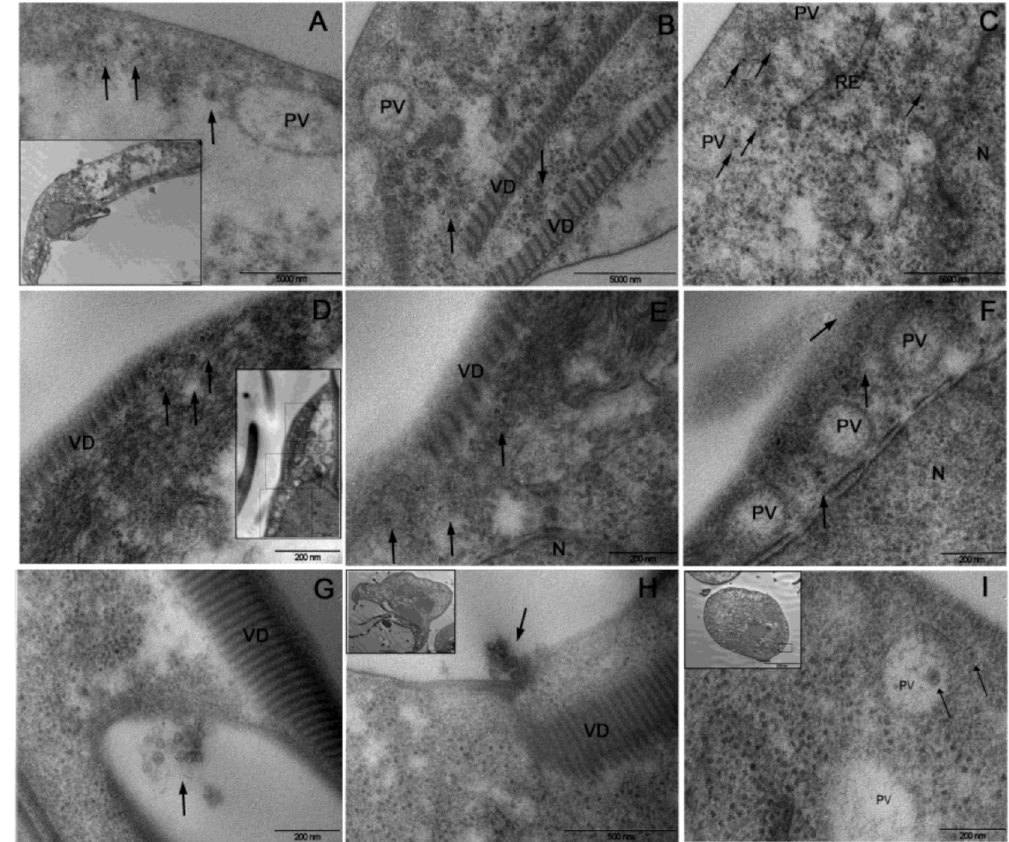
Figure 6. Transmission electron microscopy analysis of WBC6 CAT and G. duodenalis WBC6 HP tropho- zoites. ( A – C ) Electron micrographs of WBC6 CAT trophozoites (inset) at high magnification show GLVs particles localized near peripheral vesicles (Pvs) under periplasmatic membrane ad near the ventral dish. ( D – F ) Electron micrographs of WBC6 HP trophozoites (inset) at high magnification show GLV’s virus particles grouped principally under periplasmatic membrane, near PVs and outside cell near ventral disc area ( G , H ). ( I ) shows a detail at higher magnification of a virus particle inside PVs. PV, peripheral vesicles; ER, endoplasmic reticulum; N,